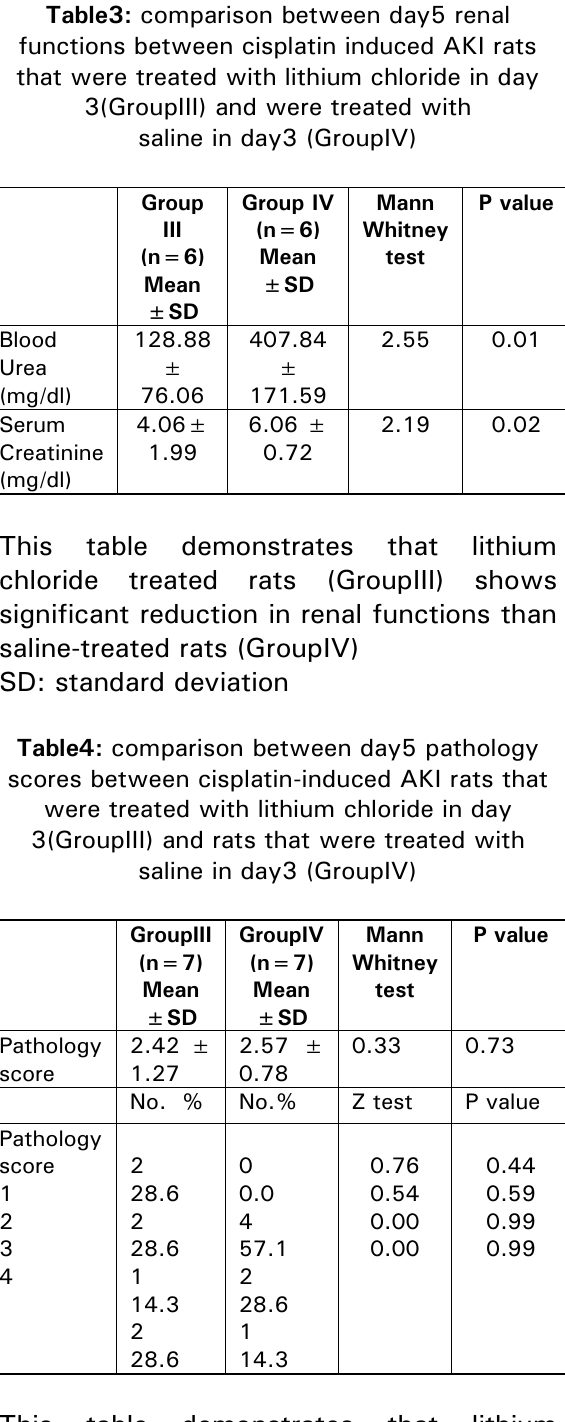
This table demonstrates that lithium chloride treated rats (GroupIII) shows improvement in pathology scores than saline-treated rats (Group